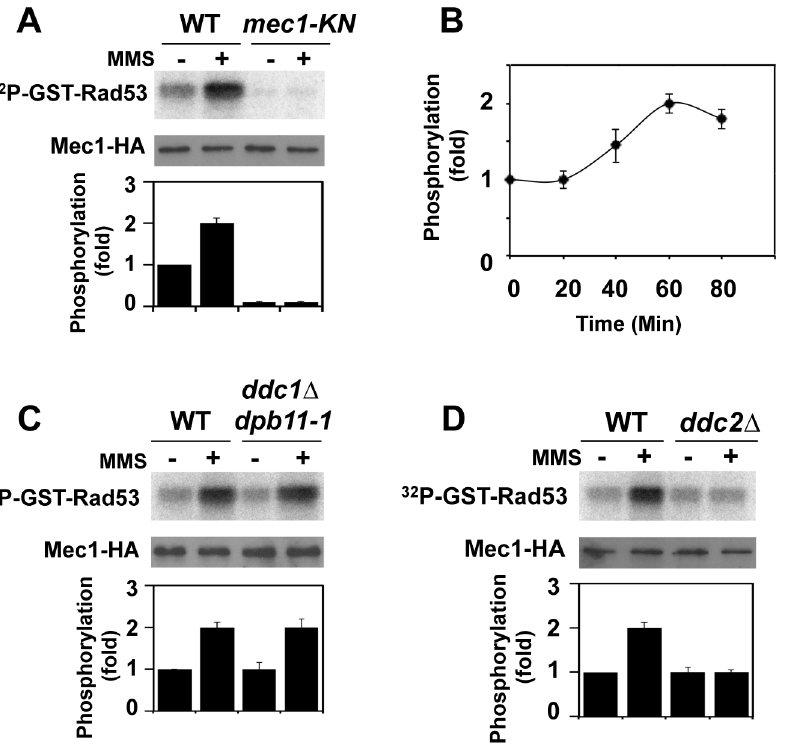
Figure 1. Regulation of protein kinase Mec1 after DNA damage. (A) Mec1 activation after MMS treatment. Cells expressing Mec1-HA (KSC1635) or Mec1-KN-HA (KSC1645) were cultured at 25 u C and incubated with nocodazole to arrest at G2/M. Cells were then either mock treated ( 2 ) or treated ( + ) with 0.05% MMS for 1 hr. Immunoprecipitated Mec1-HA was subjected to the in vitro kinase assay using GST-Rad53, a recombinant protein purified from E. coli , as a substrate. Incorporation of 32 P into GST-Rad53 was monitored by phosphorimager. The amounts of Mec1 or Mec1- KN in the immunoprecipitates were determined by immunoblotting with anti-HA antibody. Phosphorylation of GST-Rad53 was normalized to that observed with immunoprecipitated mock treated wild-type Mec1. Relative phosphorylation is determined from three independent experiments. (B) Mec1 activation kinase after incubation with MMS for various lengths of time. Cells were treated with MMS for indicated lengths of time and were subjected to the in vitro kinase assay as in A. (C) Effect of ddc1 D dpb11-1 mutation on Mec1 activation. Wild-type (KSC1333) and ddc1 D dpb11-1 (KSC3130) cells expressing Mec1-HA protein were subjected to the in vitro kinase assay as in A. (D) Effect of ddc2 D mutation on Mec1 activation. Wild- type (KSC1635) and ddc2 D (KSC1636) cells expressing HA-Mec1 protein were subjected to the in vitro kinase assay as in